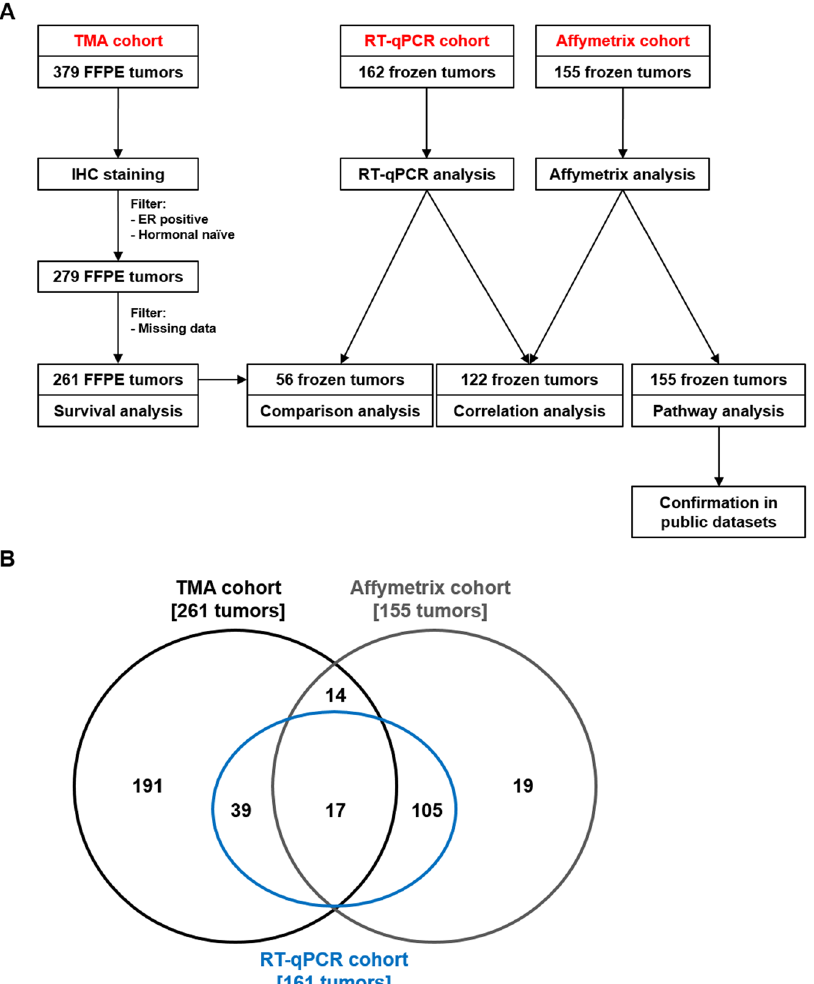
Figure 1. Schematic overview of experimental workflow. Panel A: a total of 379 FFPE tissues were captured on a tissue micro-array and analyzed by IHC. After filtering for ER positivity and hormonal naïve tumors, a total of 279 samples remained. Further filtering for missing data after IHC analysis yielded a panel of 261 tumors, on which survival analysis for the association of PSAT1 protein levels to TTP was performed. Parallel to this, PSAT1 mRNA expression was measured by RT-qPCR (n = 161) and Affymetrix chip (n = 155) approaches on frozen tumor specimens. These data were used for comparison between PSAT1 mRNA and protein levels (TMA and RT-qPCR; n = 56), correlation analysis (RT-qPCR and Affymetrix; n = 122), and pathway analysis (Affymetrix only; n = 155). Panel B shows tumor sample overlap between TMA, RT-qPCR and Affymetrix sets. Acronyms: ER: estrogen receptor; FFPE: formalin-fixed paraffin-embedded; IHC: immunohistochemistry; TMA: tissue microarray TTP: time to progression; RT-qPCR: quantitative reverse transcriptase polymerase chain